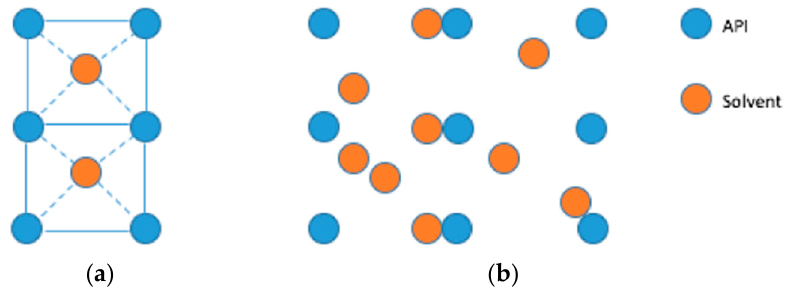
Figure 2. A simplified visualization of ( a ) a “true” solvate vs. ( b ) a non-stoichiometric solvate, where the solvent can be one or more types of solvent.